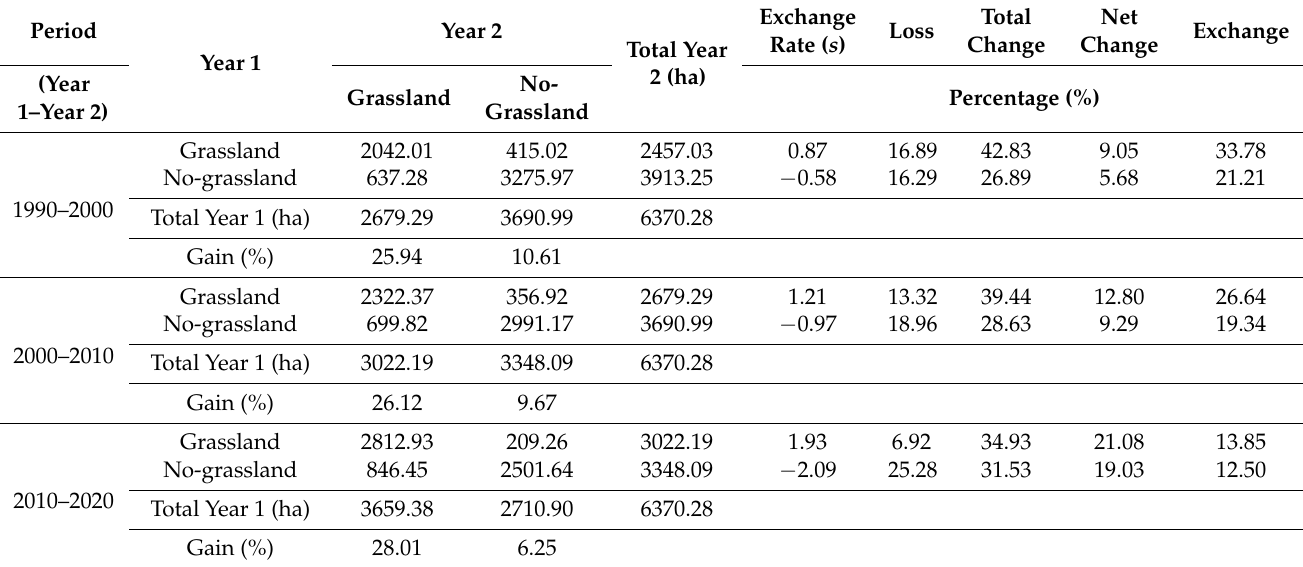
Table 4. Matrix of cross-tabulation, rate of change and indices of changes for grassland and non- grassland in the Pomacochas micro-watershed during three periods of analysis (area in ha and